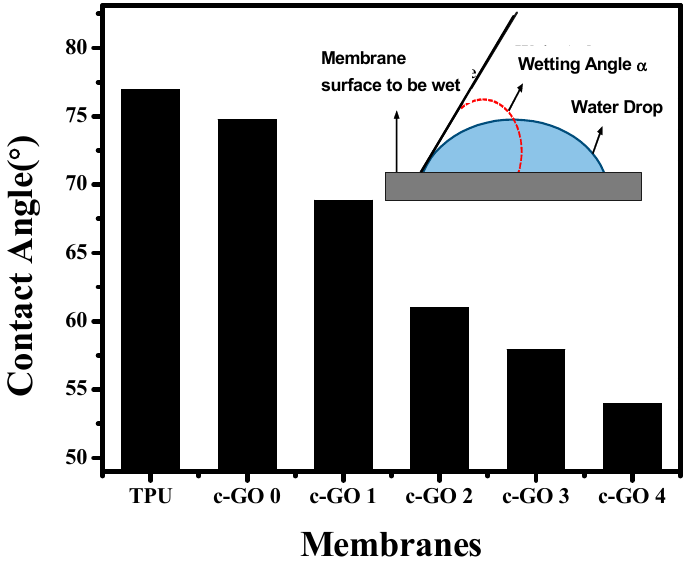
Figure 5. The contact angle of TPU and composite membranes.